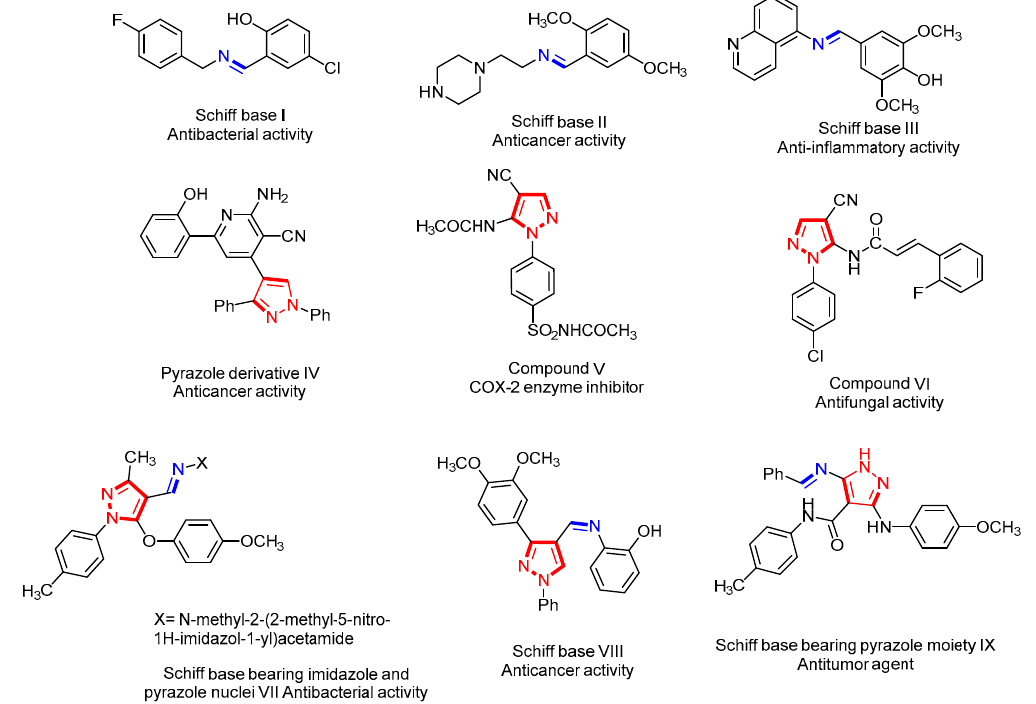
Figure 1 . Structures of bioactive Schiff bases and pyrazole compounds I–IX Figure 1. Structures of bioactive Schi ff bases and pyrazole compounds I – IX